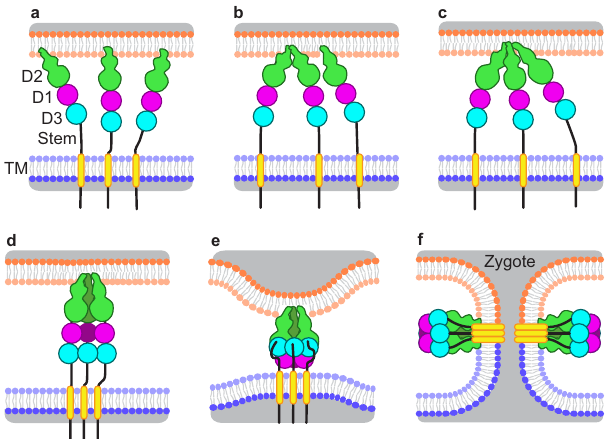
Fig. 1 Proposed model of the conformational change events in HAP2- mediated membrane fusion. a Prefusion HAP2 monomers anchored in a gamete membrane (blue bilayer) through their TM domains (yellow rectangles) interacting through their fusion loops in D2 with the gamete of opposite sex (upper orange bilayer). b HAP2 dimerization through fusion loop association in a hydrophobic environment. c HAP2 dimer